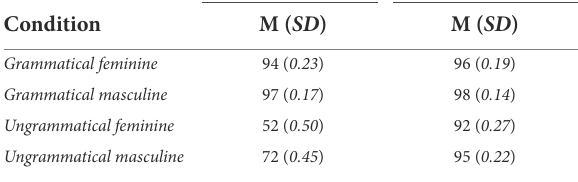
TABLE 2 Mean accuracy scores (%) and SDs per condition for HSs and homeland speakers in the